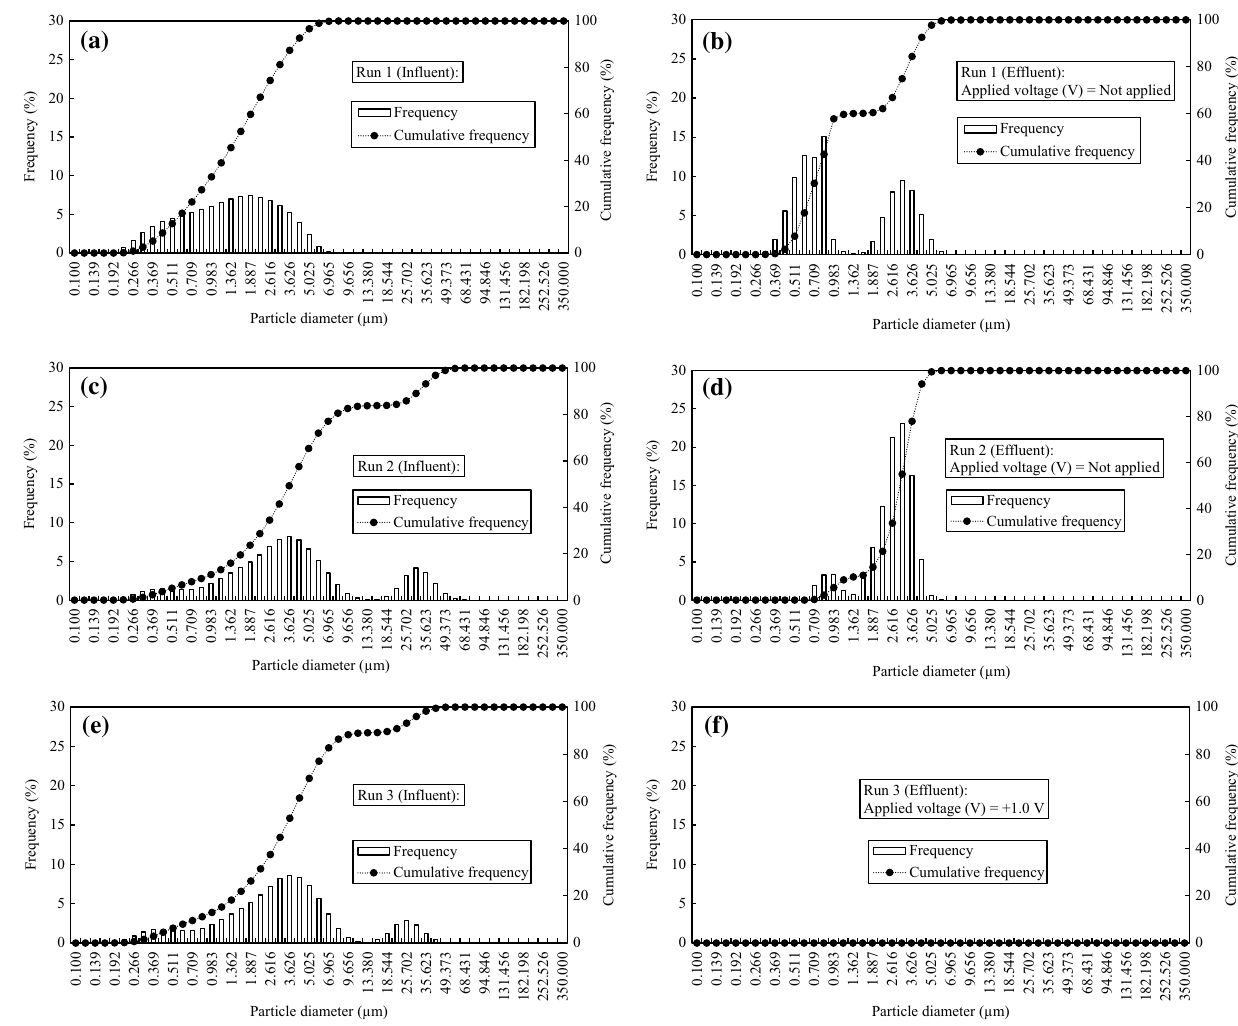
Fig. 4 a – f Volume-based kaolin suspension particle size distribution of influent and effluent of Runs 1–3, where as a solvent for kaolin particle, DW was used in Run 1 and DW with 5 mM NaCl was used in Runs